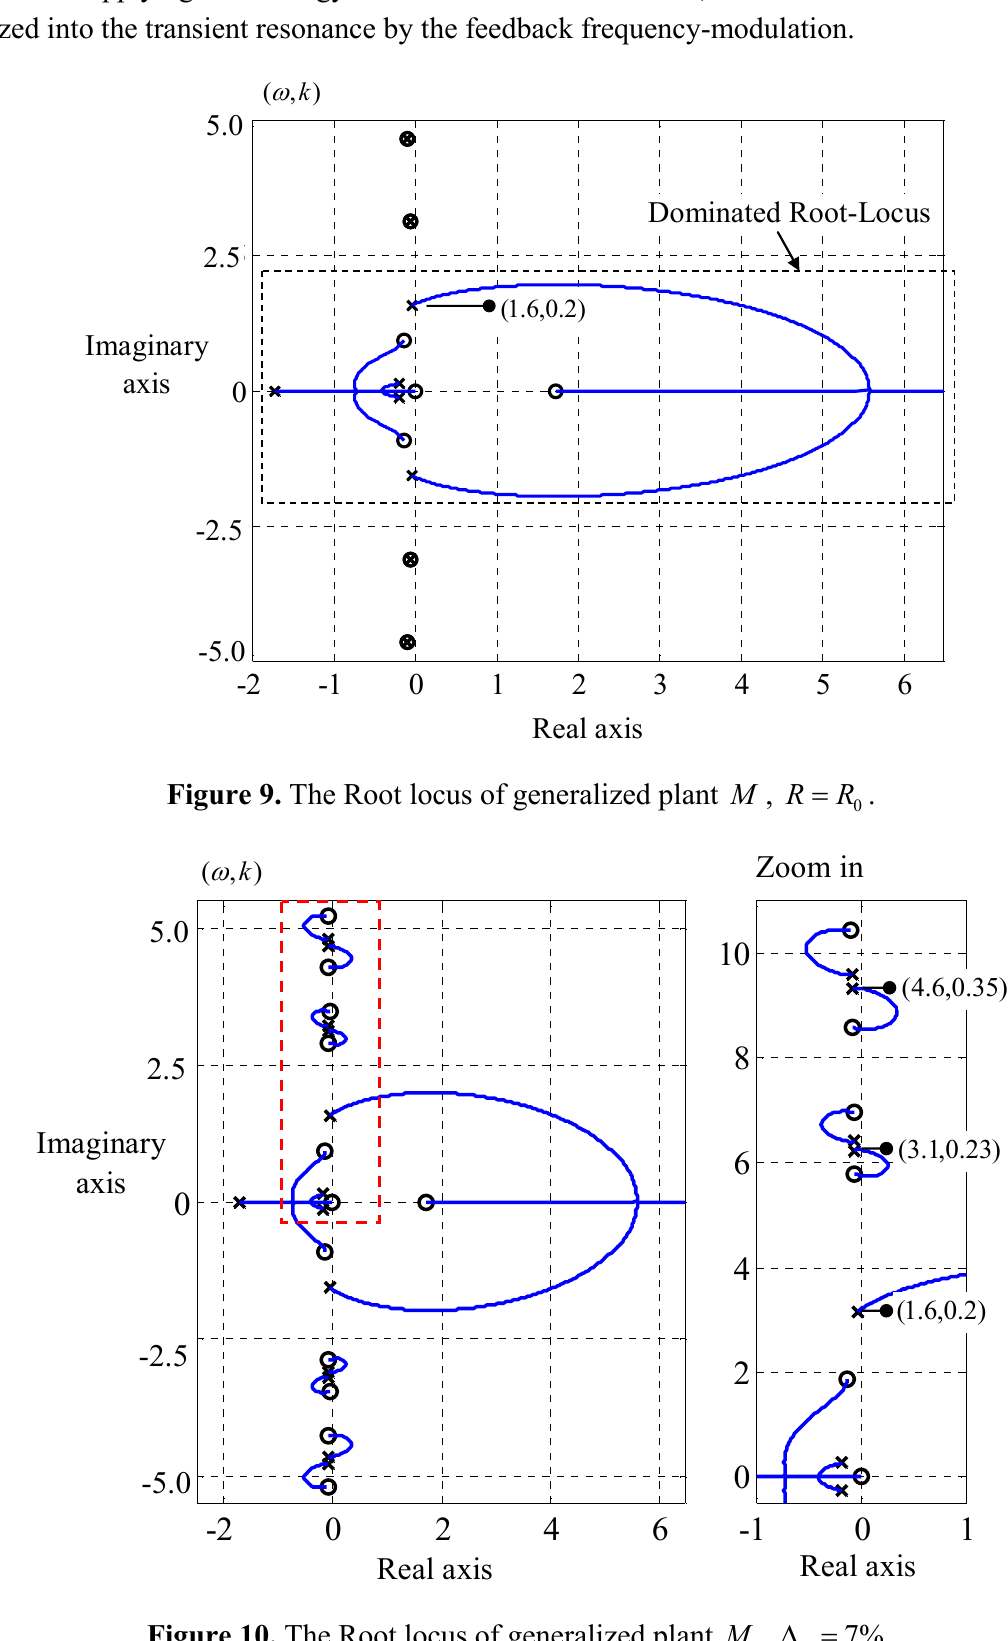
Figure 10. The Root locus of generalized plant M ,